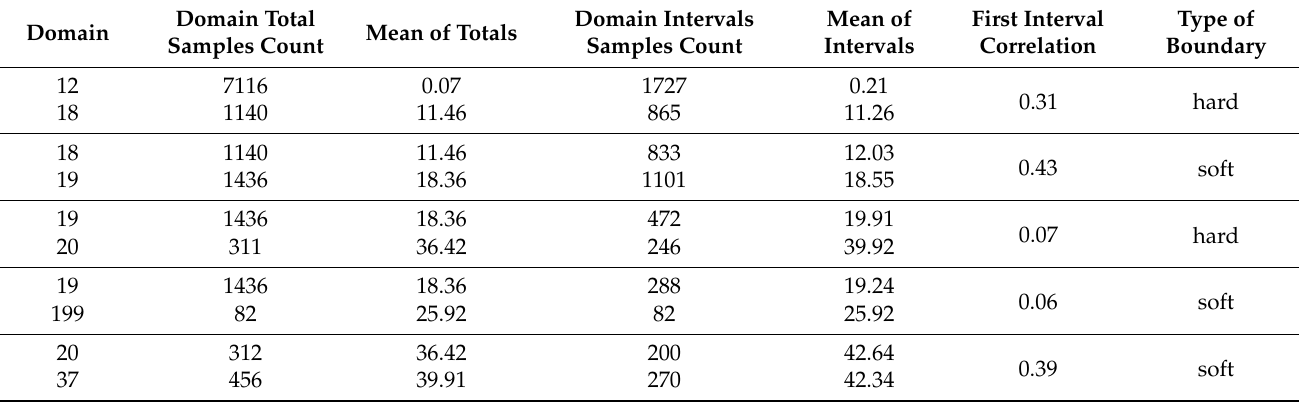
Table 2. Basic statistics of Fe samples near the interfaces between neighbouring domains and first interval